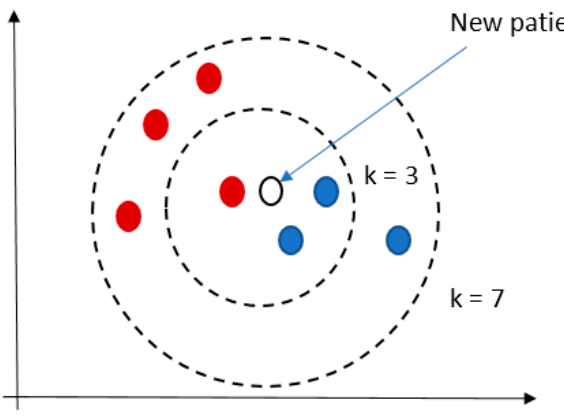
Figure 5. An example of KNN result.